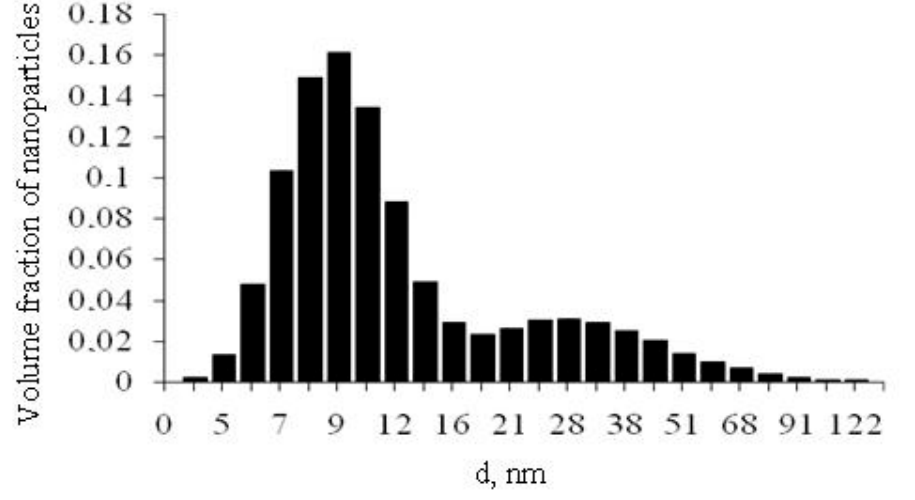
Figure 1. The particle sizes distribution in the hydrothermal sol sample, determined by dynamic light scattering.